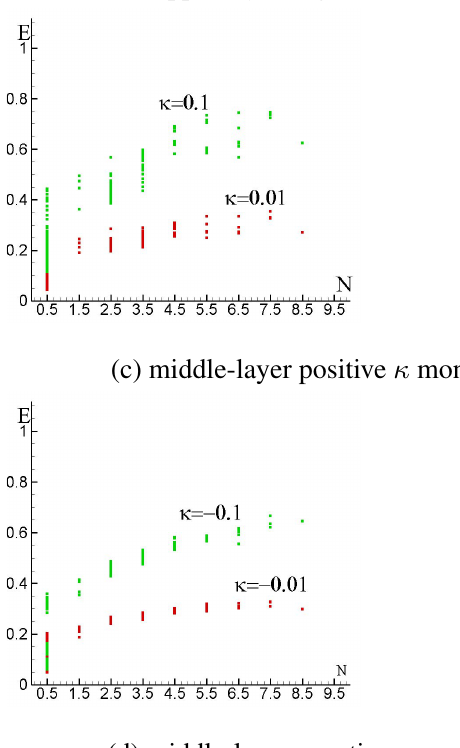
Fig. 13. Lagrangian advection efficiency E depending on monopole revolution number N Fig. 13: Lagrangian advection efficiency E depending on monopole revolution number N .